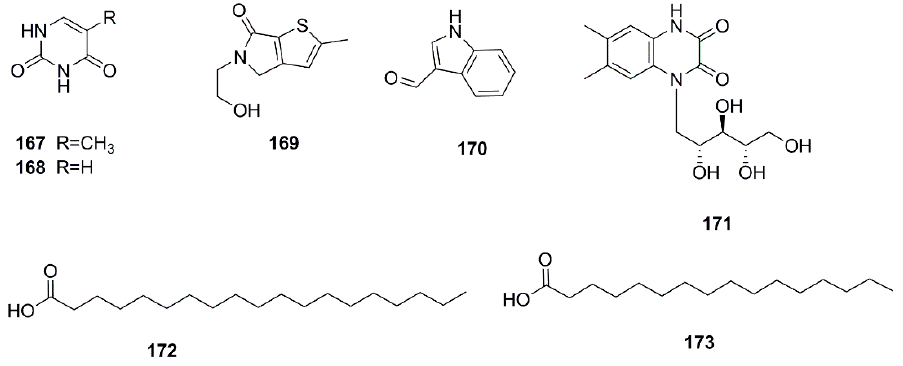
Figure 12. Chemical structures of other compounds in X. strumarium.